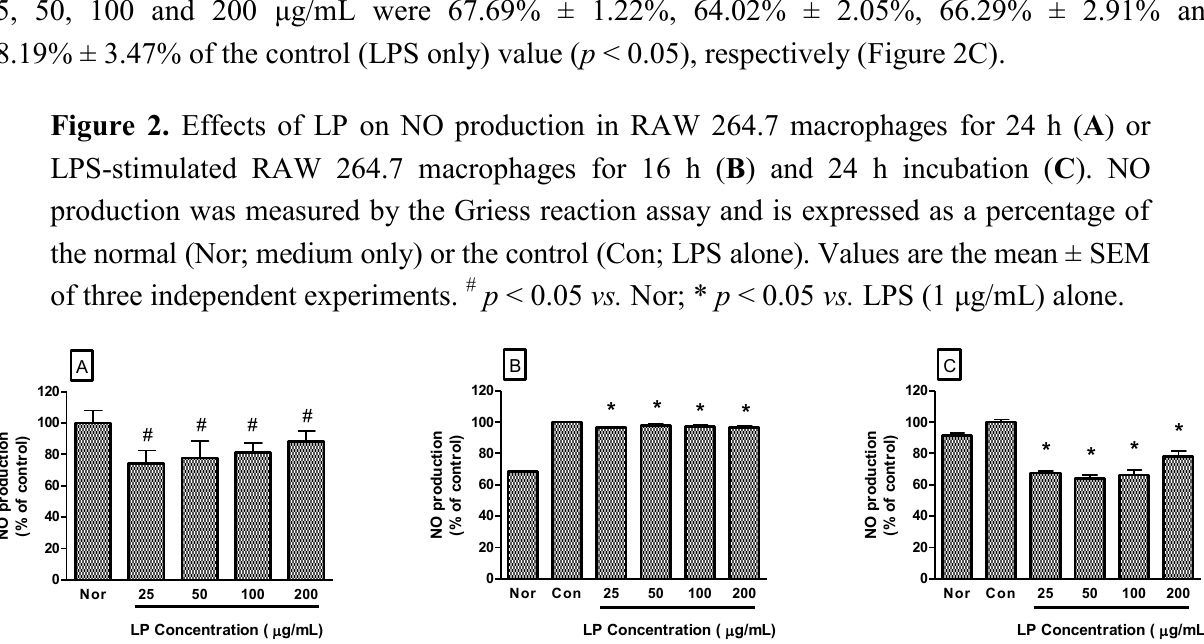
NO production by RAW 264.7 cells incubated only with LP at concentrations of 25, 50, 100 and 200 μg/mL for 24 h were 74.37% ± 8.14%, 77.65% ± 10.82%, 81.12% ± 6.06% and 88.25% ± 6.78% of the normal (medium only) value ( p < 0.05), respectively (Figure 2A). In the case of RAW 264.7